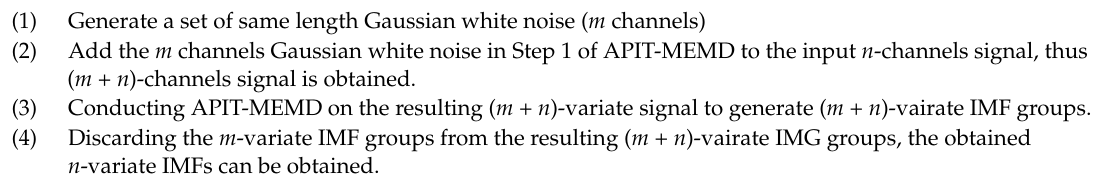
Figure 1. Adaptive projection vectors by adopting the proposed strategy ( α = 0, 1). Table 2. The detailed procedures of adopting filter bank property of